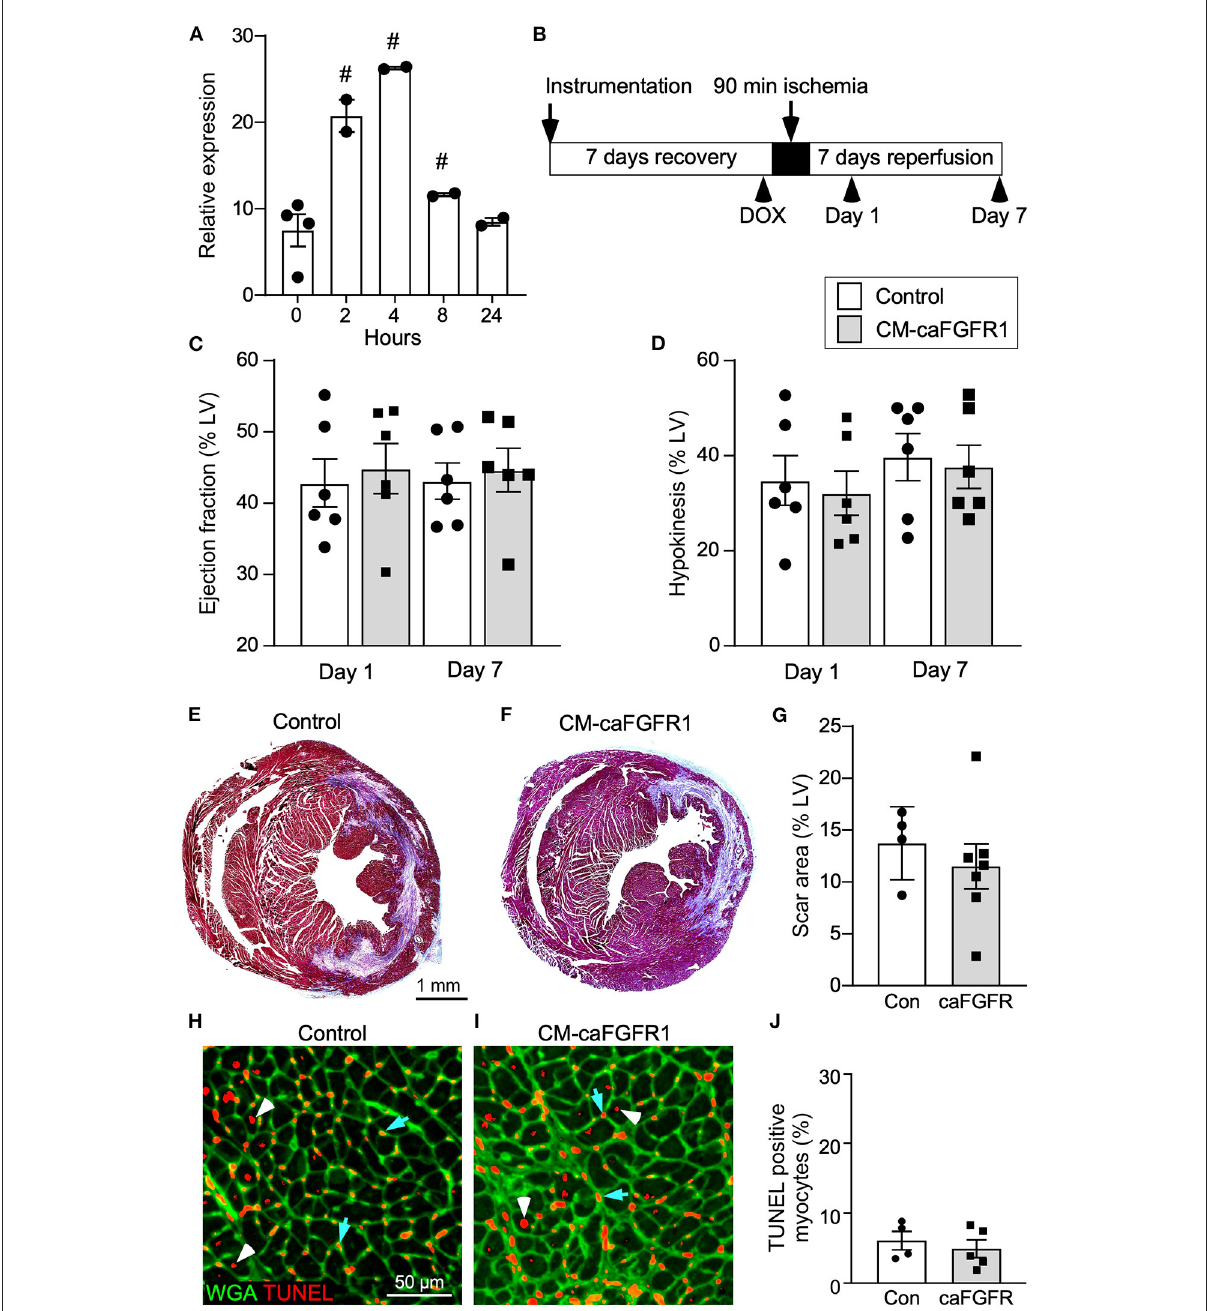
FIGURE5 Conditional targeting of an inducible constitutively-active FGFR1 in adult cardiomyocytes. (A) Quantitative RT-PCR (TaqMan ® ) of the whole left ventricle from CM-caFGFR1 mice shows rapid induction and peak expression of caFGFR1 4h after an IP injection of DOX (100 µ g). # p < 0.05 relative to time 0. (B) Schematic showing experimental plan and analysis time points for cardiomyocyte activation of FGFR1. DOX (100 µ g) was injected IP 4h before ischemia. (C,D) Compared to sham operated mice (not shown), both Control and CM-caFGFR1 mice show a similarly decreased ejection fraction (C) and increased hypokinetic area (D) 1 day after reperfusion that was unchanged 7 days after reperfusion. (E–G) Histological analysis of scar area (Masson’s trichrome stain) 7 days after reperfusion. Relative to Control (E,G) , CM-caFGFR1 hearts (F,G) show similar scar area. n = 4–7; Scale bar = 1mm. (H–J) Analysis of cell death in the periinfarct region 1 day after reperfusion showing similar numbers of TUNEL positive (red), WGA positive (CF ® 640R, green) myocytes in CM-caFGFR1 hearts (I,J) compared to Control hearts (H,J) . Scale bar = 50 µ